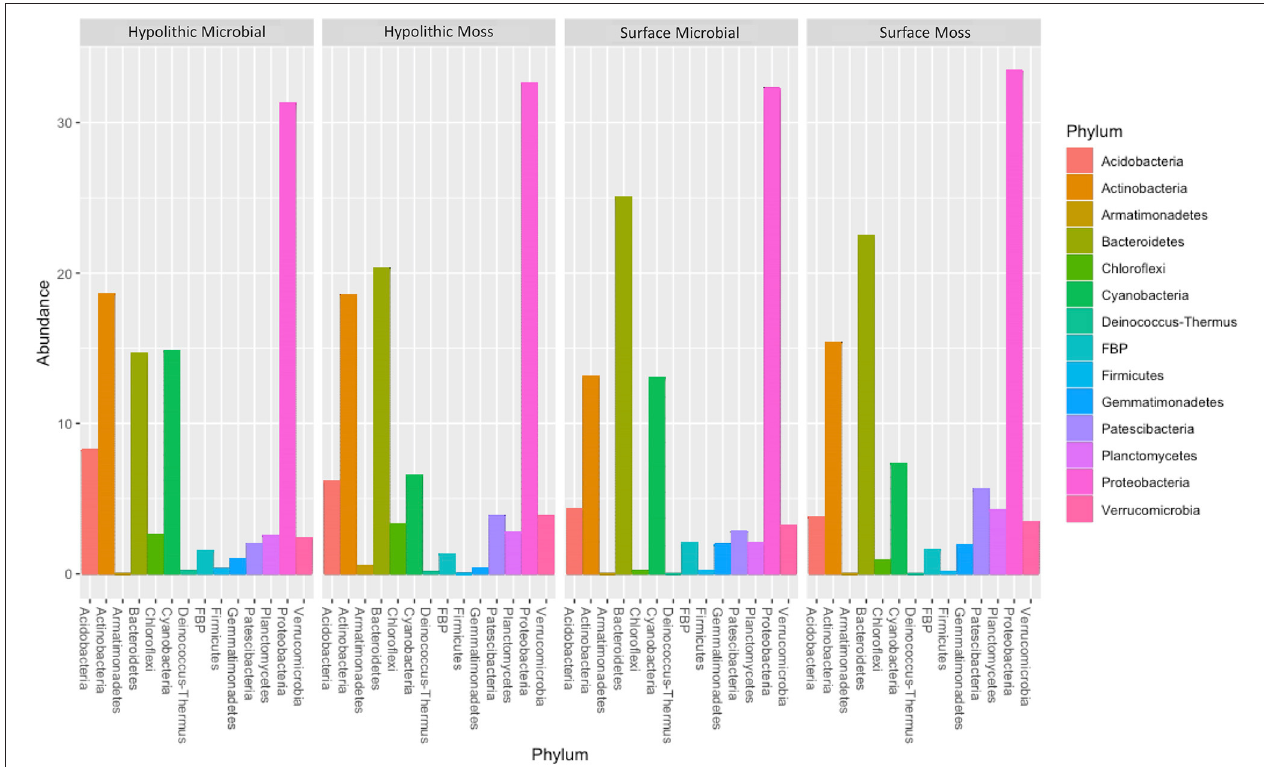
FIGURE 4 | Community profile plots showing the relative abundance of all phyla found in the four sampled biocrust habitats ( N = 7 for each habitat). OTUs with < 0.01% abundance across all samples were removed prior to analysis; remaining abundance data were normalized through cumulative-sum scaling and log transformed.